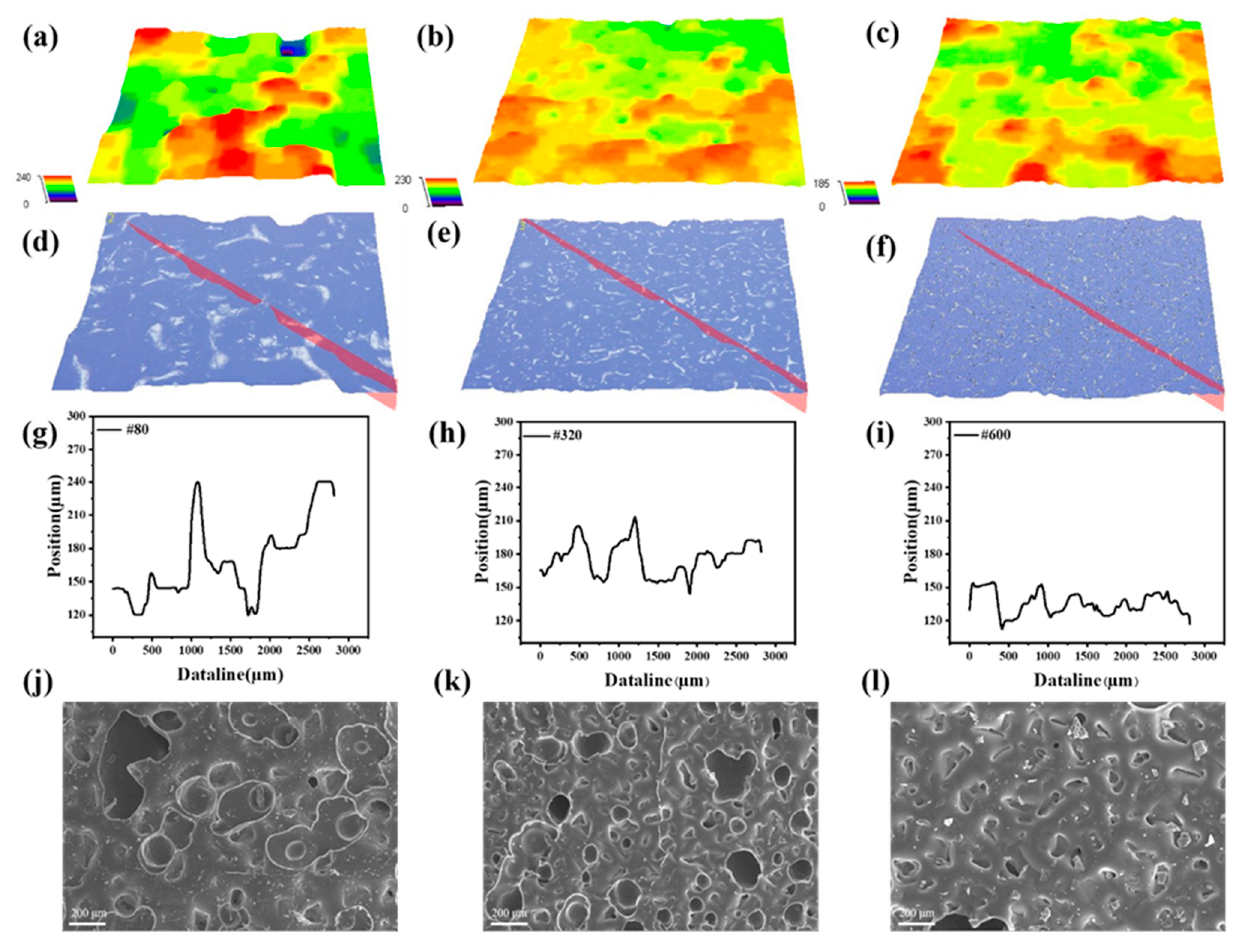
Figure 3. Characterization of the pressure sensors. The 3D morphology of spinosum CNT/PDMS dielectric layer using abrasive papers no. ( a ) 80, ( b ) 320 and ( c ) 600. The position of the marker line of the CNT/PDMS dielectric layer using abrasive papers no. ( d ) 80, ( e ) 320 and ( f ) 600. Height profile corresponding to the marked line on the diagonals using abrasive papers no. ( g ) 80, ( h ) 320 and ( i ) 600. The SEM images of the spinosum CNT/PDMS dielectric layer using abrasive papers no. ( j ) 80, ( k ) 320 and ( l ) 600.